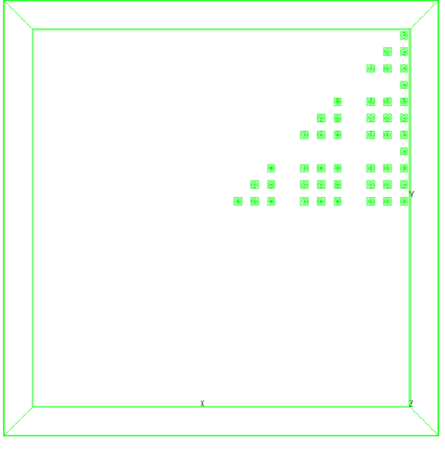
Figure 17. The 1/8 model of type C. / 8 model of type Figure 17. The 1/8 model of type C. Figure 17. The 1 Figure 17. The 1/8 model of type C.